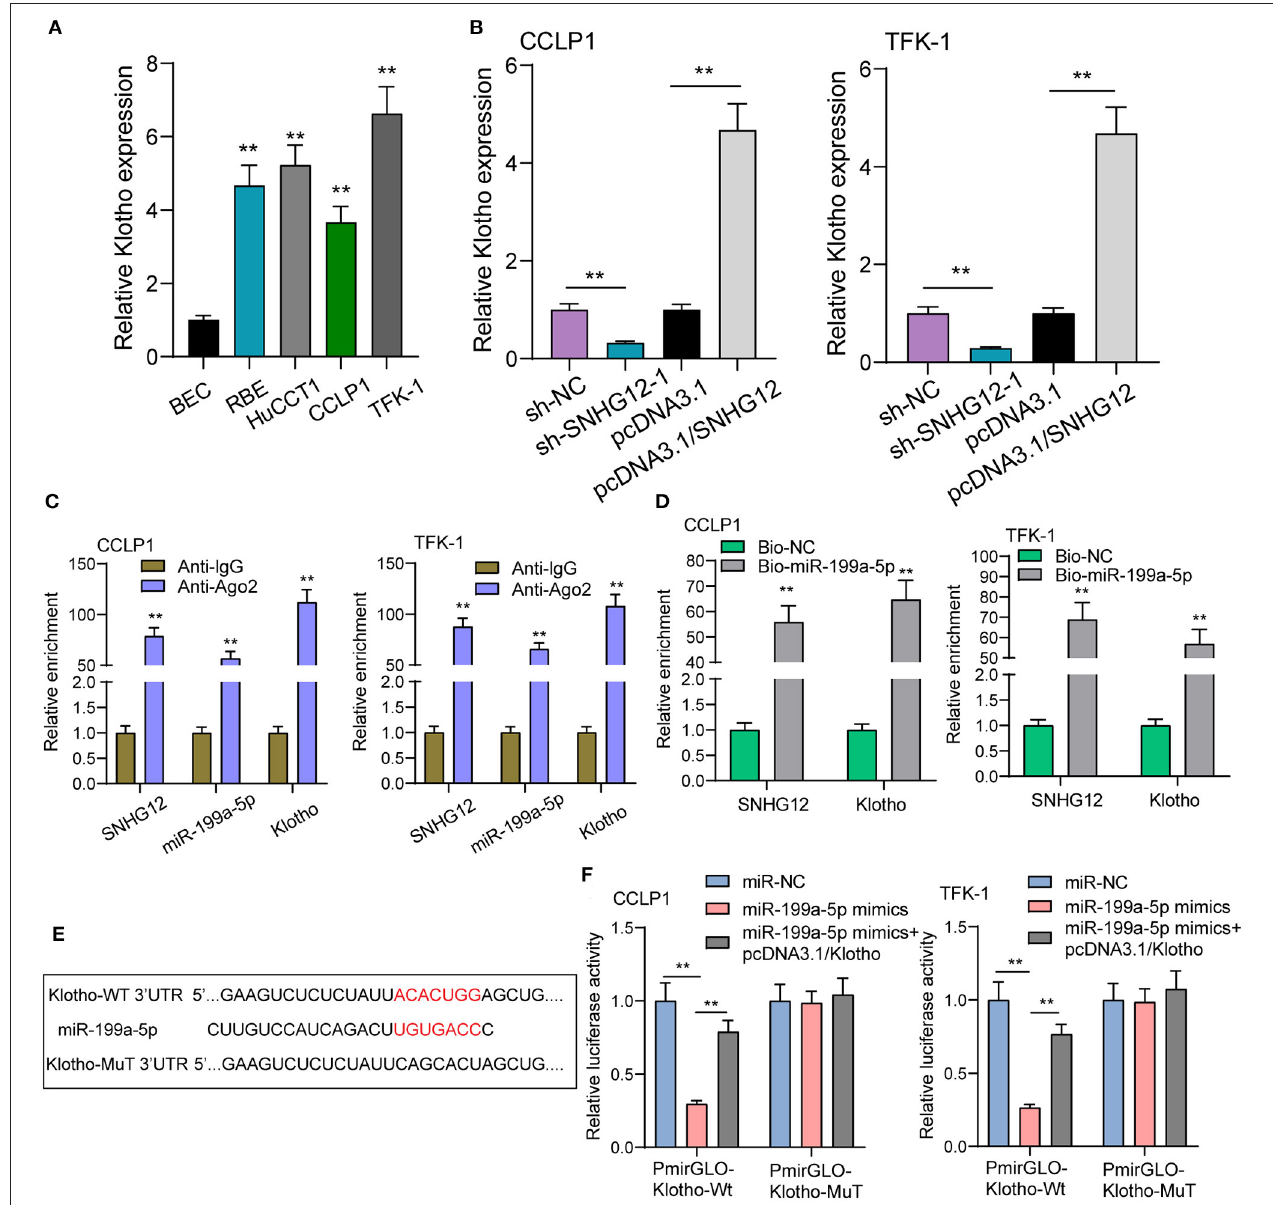
FIGURE 5 | Klotho is a target gene of miR-199a-5p. (A) Four ICC cells exhibited an increased expression of Klotho compare with BEC cells using RT-PCR. (B) RT-PCR for the expression of Klotho in TFK-1 and CCLP1 cells transfected with sh-NC, sh-SNHG12-1, pcDNA3.1 or pcDNA3.1/SNHG12. (C) RIP assays to verify the coexistence of three molecules. (D) RNA pull-down assay to test enrichment of SNHG12 and Klotho pulled down by miR-199a-5p. (E) Schematic representation of the predicted target site for miR-199a-5p in SNHG12. (F) Luciferase reporter assay in TFK-1 and CCLP1 cells, co-transfected with the reporter plasmid and the indicated miRs. ** p <